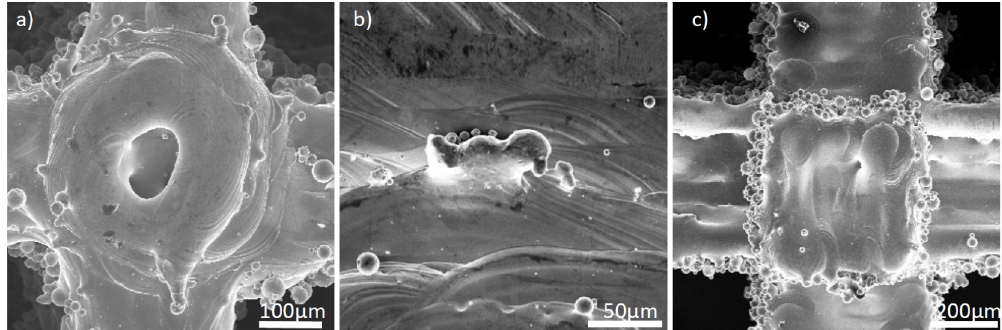
Figure 3. Structure of melted powders during selective laser sintering with the participation of the liquid phase of porous skeletons in a direction perpendicular to the working platform made of the following powders: ( a , b ) CoCr25W5Mo5Si alloy; ( c ) Ti6Al4V alloy (SEM).